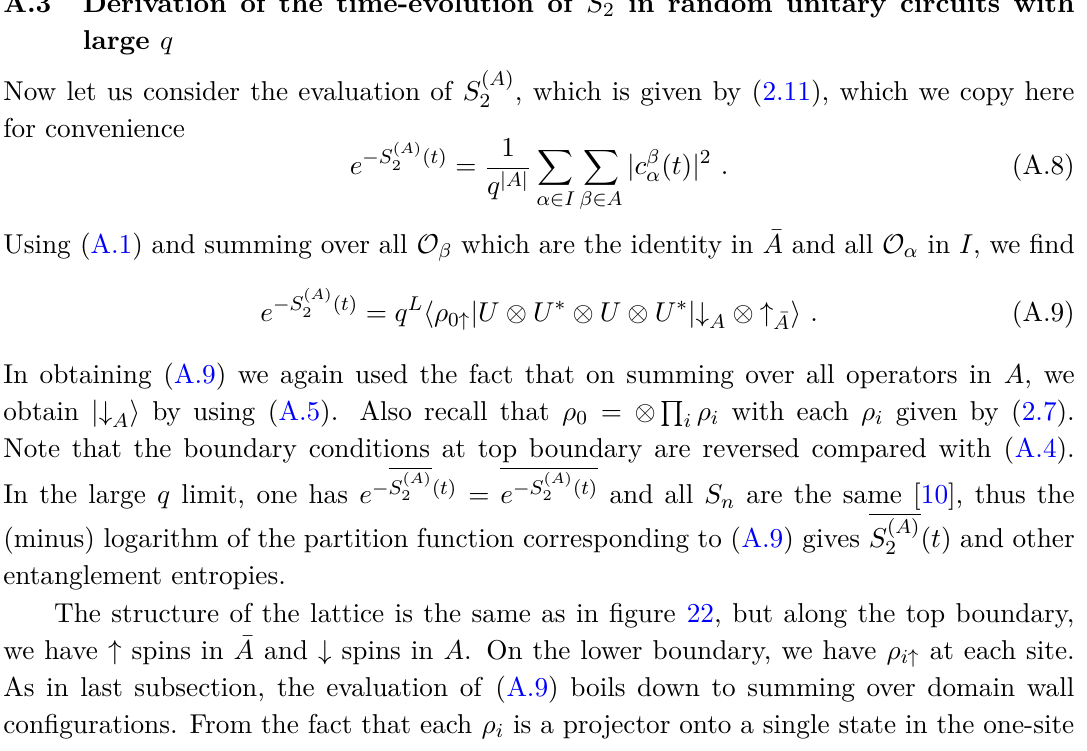
Figure 26 . A domain wall configuration that contributes to P ( A ) operator O α has a single void in region G , and A is a single interval. This configuration describes processes in which the disconnected parts of O α evolve independently to left and right of A . This contribution evaluates to q −| A | + | G |− 2 t , and is bigger than the contribution from figure 24 for t < ( | G | + | A | ) / 2